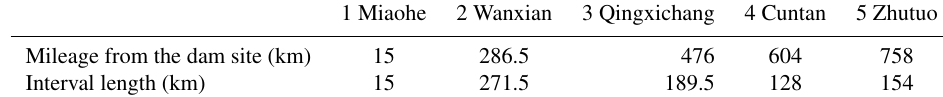
Table 2. Mileages of upstream and downstream from the Dam of the Three Gorges.